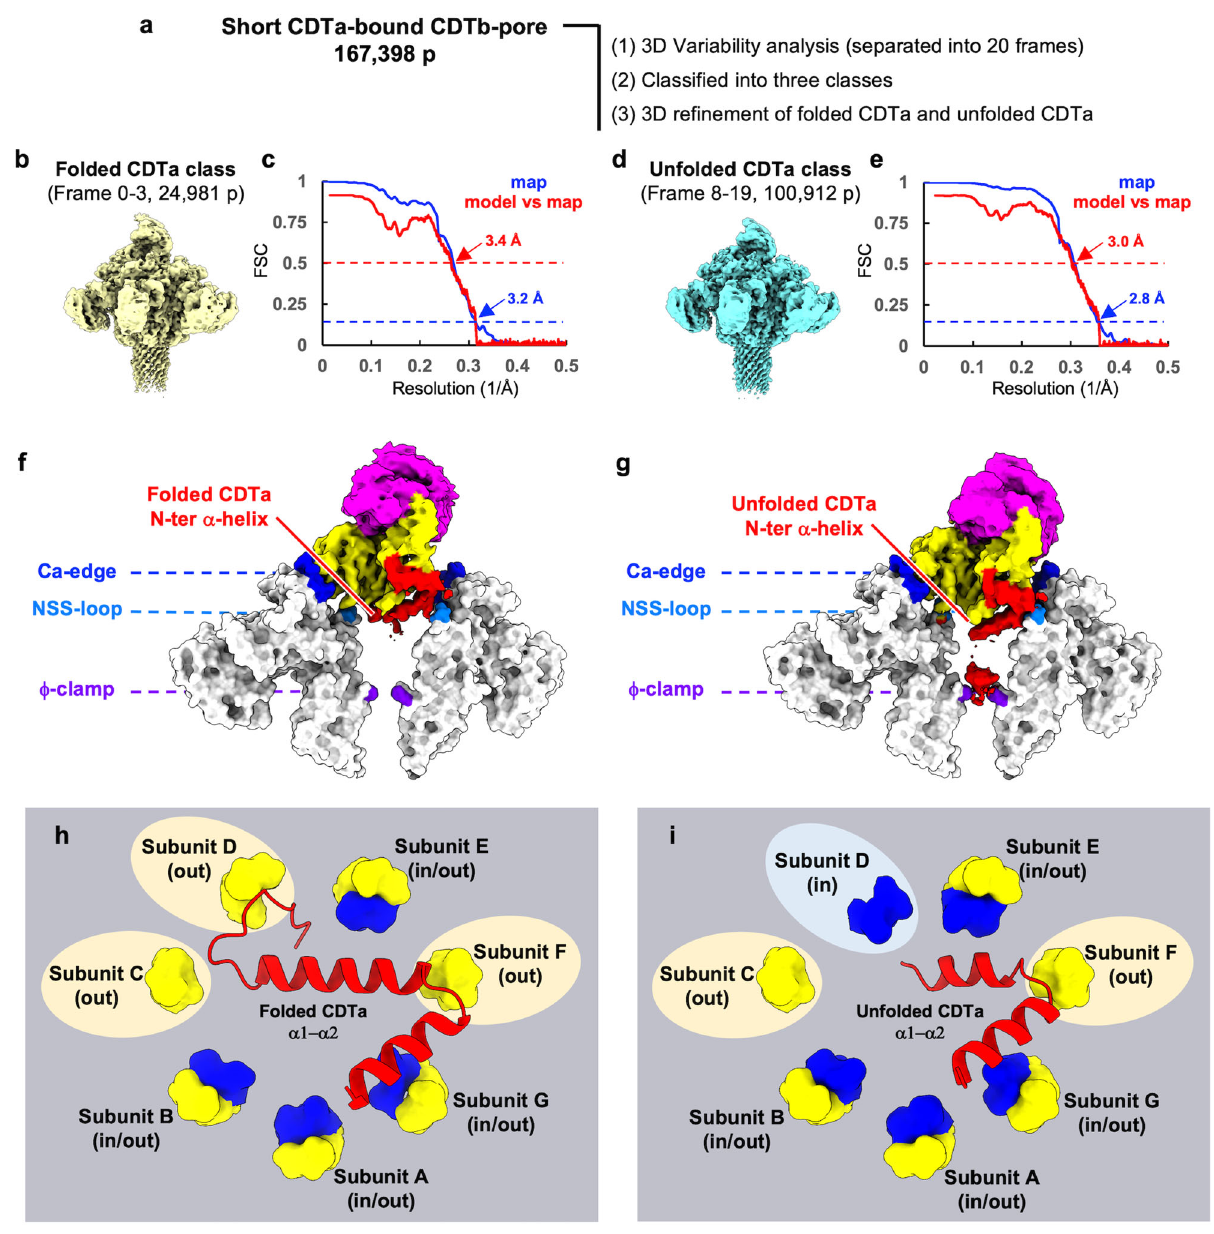
Fig. 6 | 3D variability analysis from the short CDTa-bound CDTb-pore. a Flow chart of cryo-EM image processing with 3D variability analysis. The short CDTa- bound CDTb-pore particles were classi fi ed into the folded CDTa class and the unfolded CDTa class, followed by 3D re fi nement respectively. More detailed information is described in result and method. b The density map of the folded CDTaclass. c FSCcurveofthehalfmapsandFSCcurveforcross-validationbetween the map and modeloffoldedCDTaclass. d The density mapofthe unfolded CDTa class. e FSC curve of the half maps and FSC curve for cross-validation between the